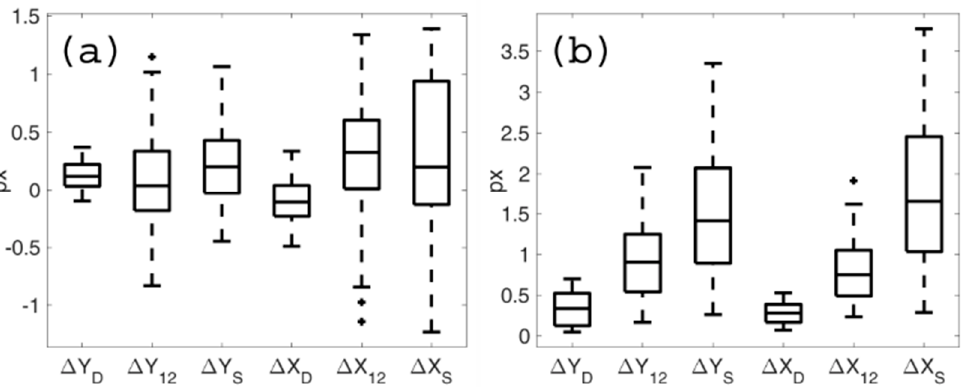
Figure 5. Boxplots of ( a ) mean and ( b ) standard deviation of CC. Subscripts D, 12 and S are as follows: D represents images acquired respectively with di ff use illumination, 12 denotes images with direct illumination taken at a fixed hour of the day (i.e., 12:00), and S concerns images taken in direct illumination with di ff erent sun azimuths and elevation